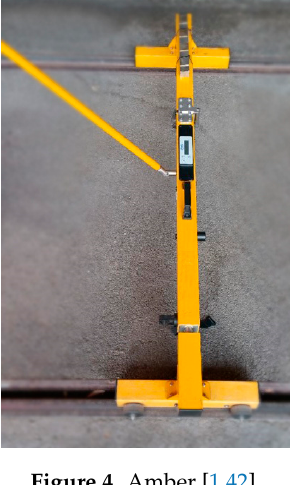
Figure 4. Amber [1,42]. Table 1. AMBER measurement specifications.